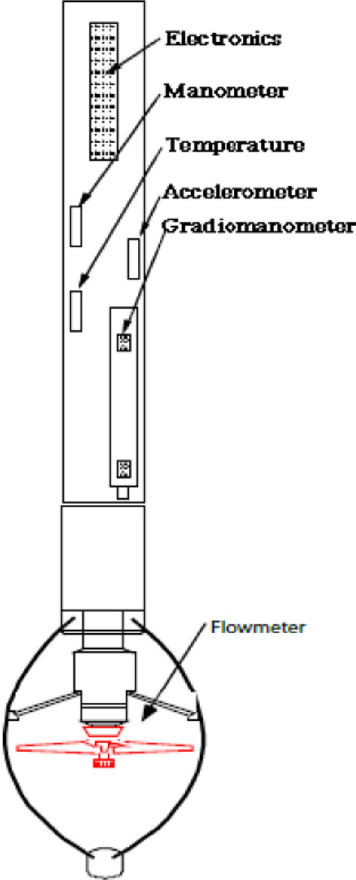
Fig. 2 Production logging tools